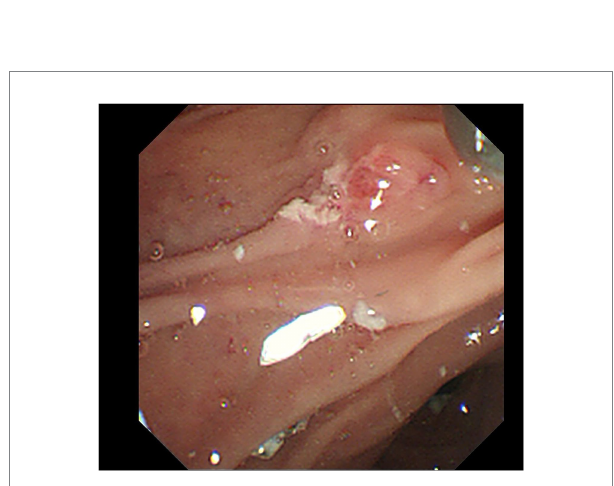
FIGURE 4 The Dieulafoy’s lesion was located at the 9 o ‘clock position of the duodenal